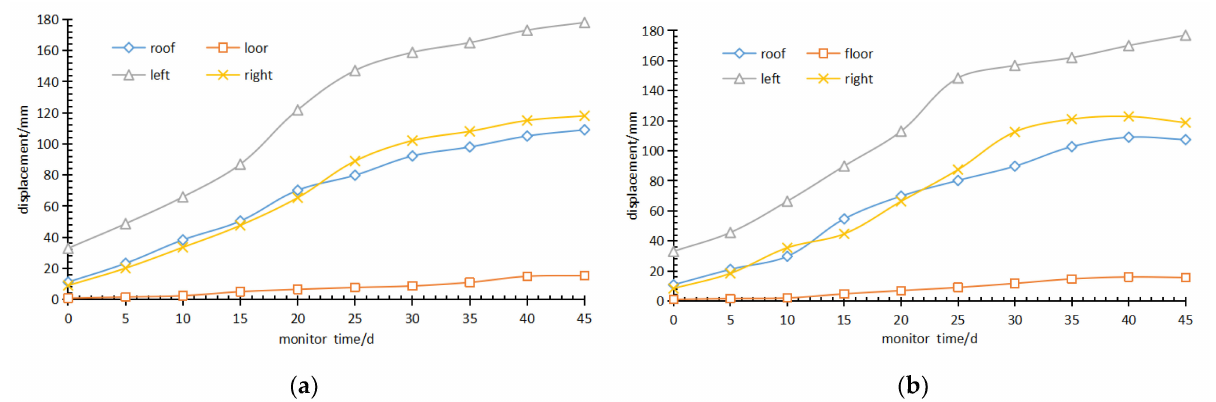
Figure 13. Deformation of the roadway surrounding rock during 1203 transport heading: ( a ) no. 1 station; ( b ) no. 2 station.